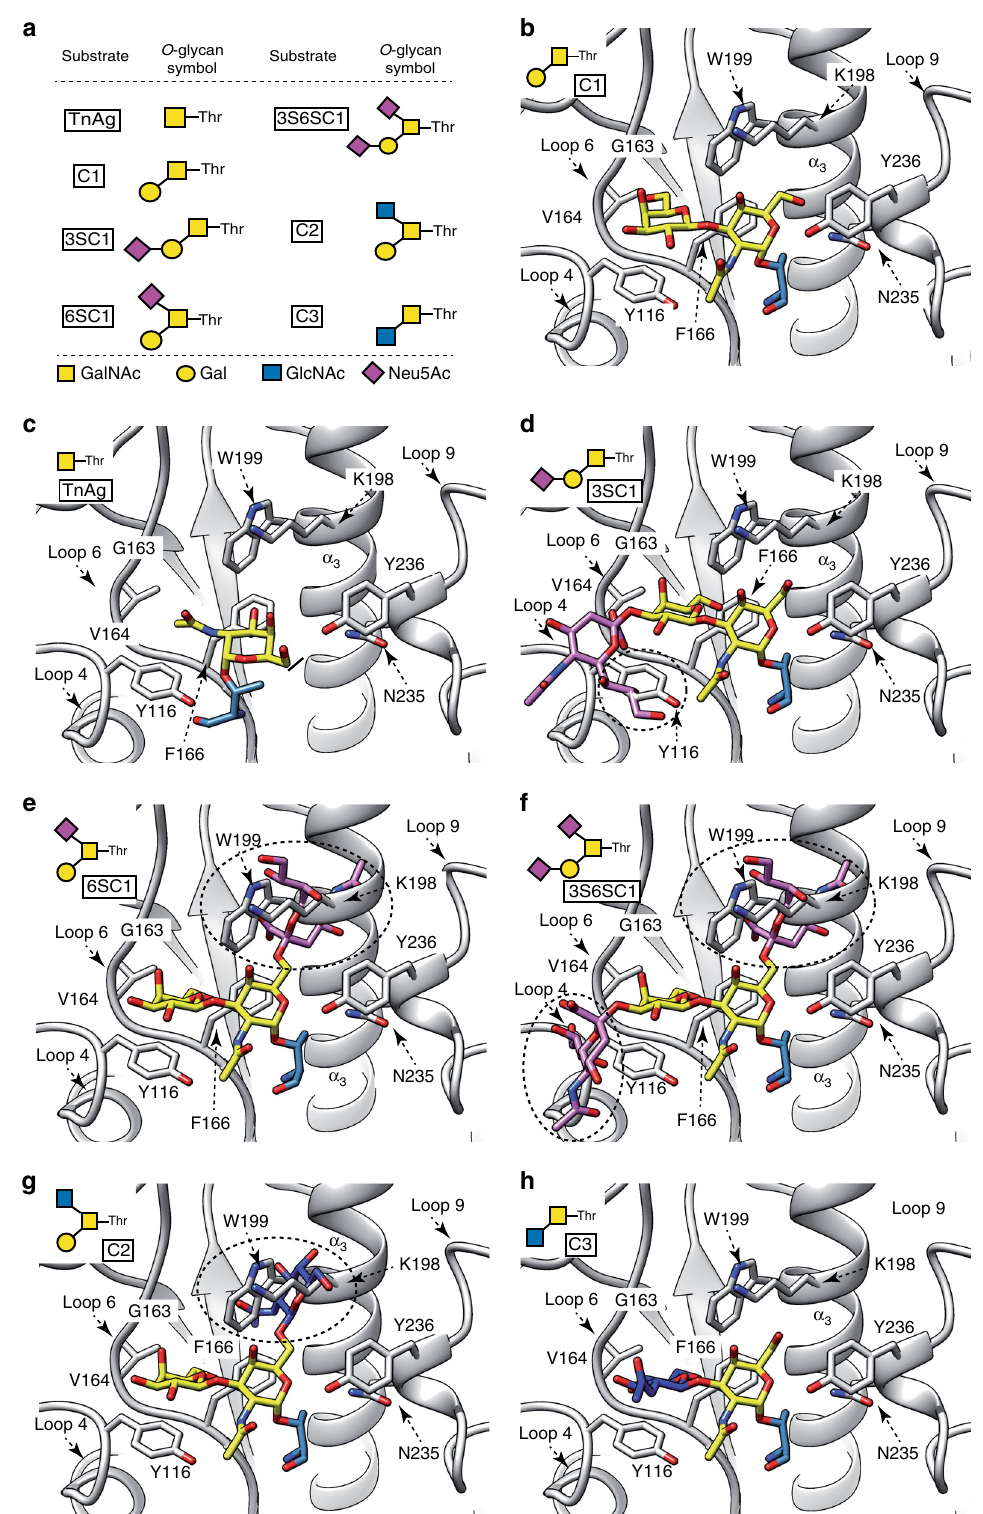
Fig. 4 Structural basis of OgpA speci fi city for O -glycopeptides. a O -glycopeptides used to measure OgpA activity by reverse-phase HPLC. b X-ray crystal structure of OgpA WT -GD-PRO with C1 glycan. Docking calculations of OgpA with different O -glycans, including c Tn, d 3SC1, e 6SC1, f 3S6SC1, g C2 and h C3. The predicted clashes are shown as dotted